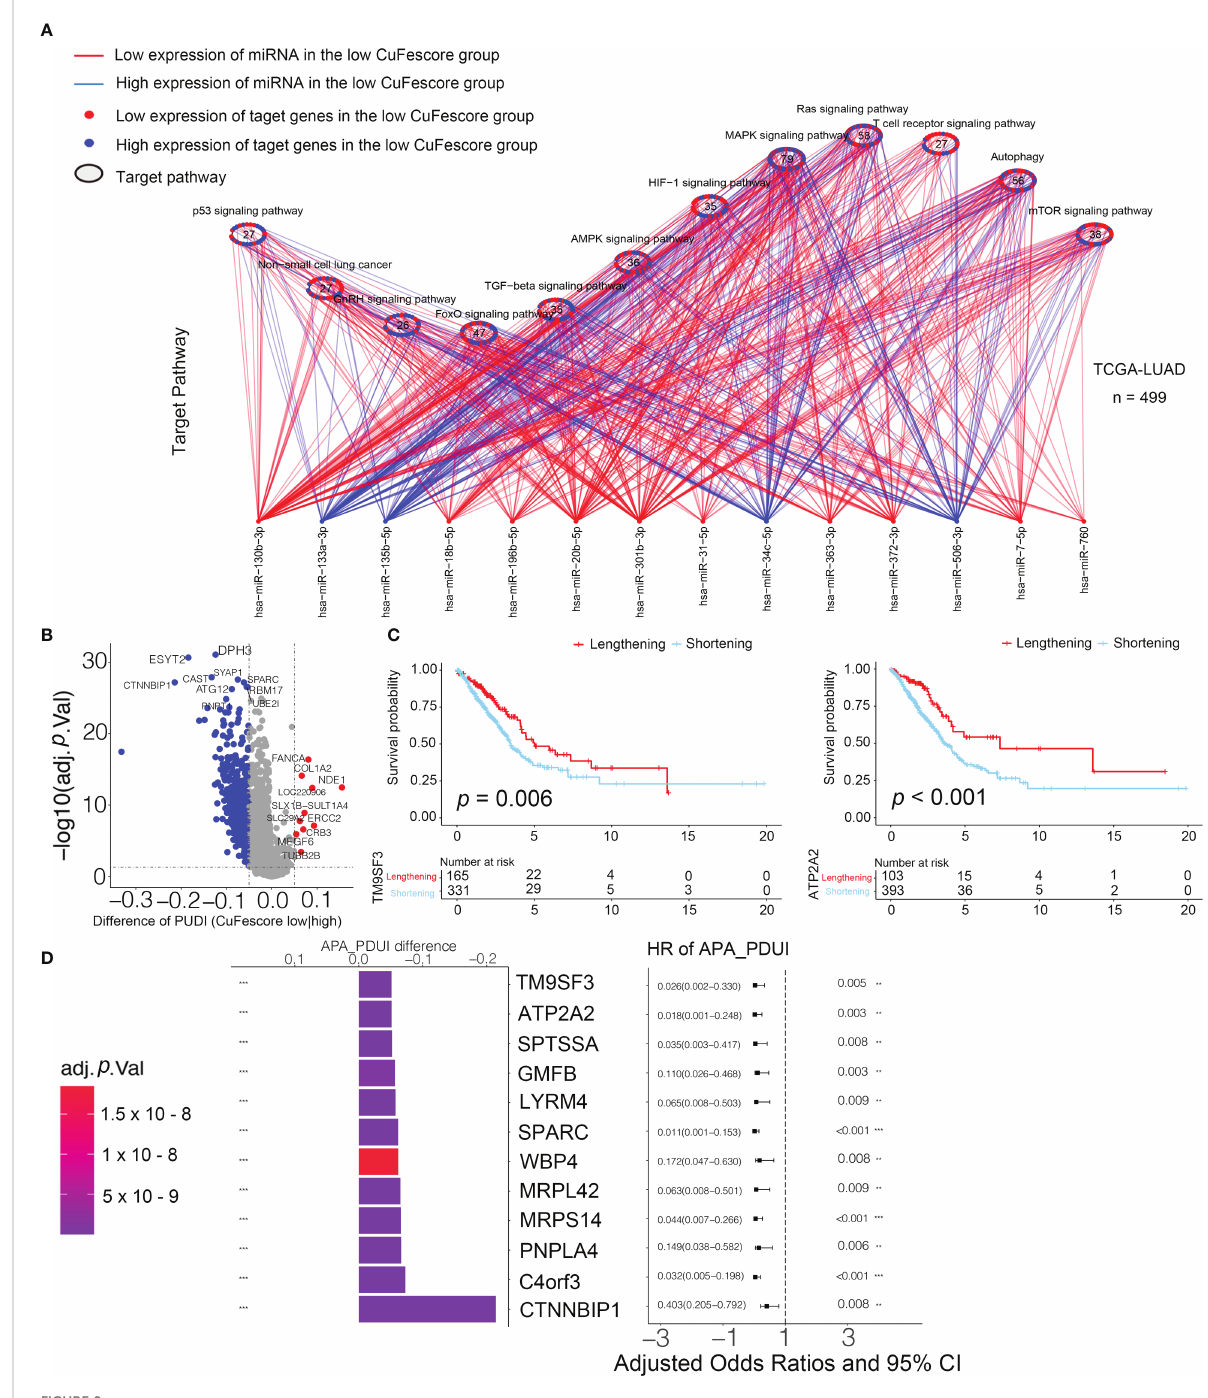
FIGURE 9 Associated between the CuFescore and the post-transcriptional characteristics. (A) Differences in miRNA-targeted signaling pathways in the TCGA- LUAD cohort between the high and low CuFescore groups. (B) Differences in the distal poly (A) site usage index (PDUI) of each gene between the high and low CuFescore groups. Red, PDUI lengthening; blue, PDUI shortening; Grey, no signi fi cant change in PDUI. (C) Kaplan-Meier curves indicated overall survival between PDUI lengthening (red) and PDUI shortening (blue) of TM9SF3 and ATP2A2. (D) Bar graphs showed the difference in the distal poly (A) site usage index (PDUI), and the forest plots showed univariate Cox regression analyses for PDUI differential genes between the high and low CuFescore groups. APA, alternative polyadenylation. HR, hazard ratio. CI, con fi dence interval. ** p < 0.01, *** p <